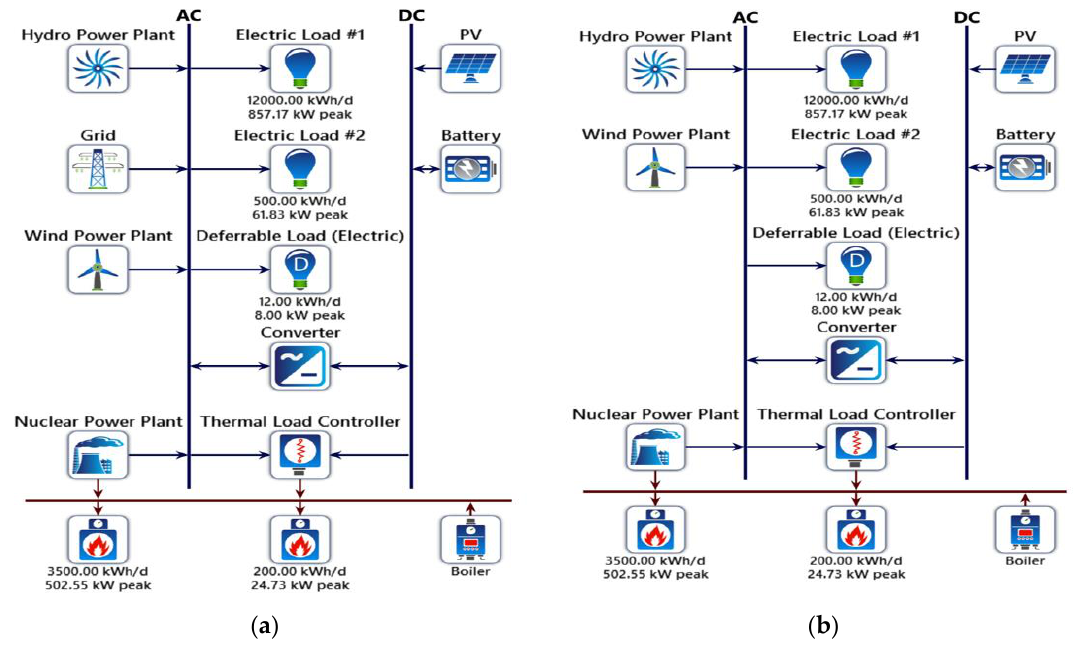
Figure 12. ( a ) Grid-connected nuclear-renewable micro hybrid energy system; ( b ) Off-grid nuclear-renewable micro hybrid energy system.